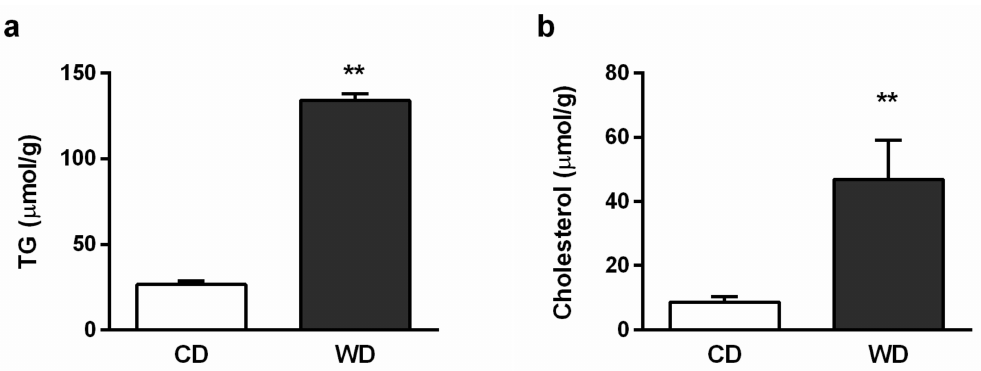
Figure 3. Hepatic lipids in mice fed a control diet (CD) and a Western ‐ style diet (WD). ( a ) Total triglycerides (TGs) and ( b ) cholesterol content. The results are expressed as the means ± SD; ** p < 0.01 ( n = 6 each group).